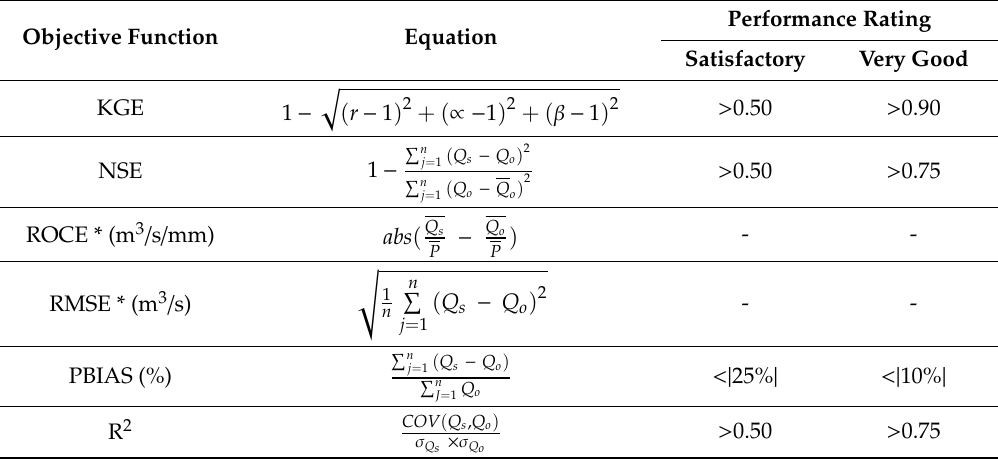
Table 2. Objective function equations and reference performance rating (subtracted from [64,65]). Objective Function Equation